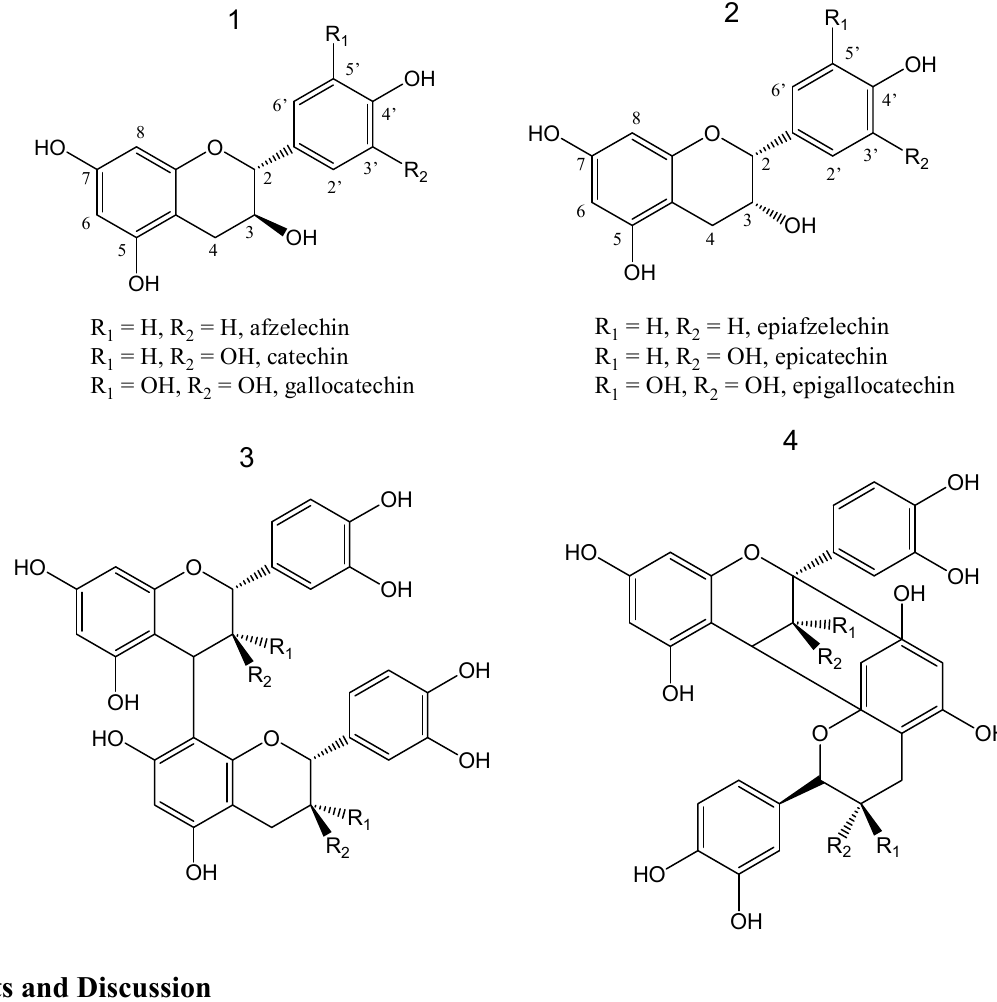
Figure 1. Structures of the flavan-3-ol building blocks ( 1 and 2 ) of proanthocyanidins, B-type ( 3 ) and A-type ( 4 ) dimeric blocks of proanthocyanidins. B-type (dimeric) are characterized by single linked flavanyl units between C-4 and C-8 (3) or C-6 (not shown), while A-type possess an additional ether linkage between C-2 of the upper unit and a 7- and/or 5-OH of the lower unit. Where R R = H, epicatechin [3,6]. 2